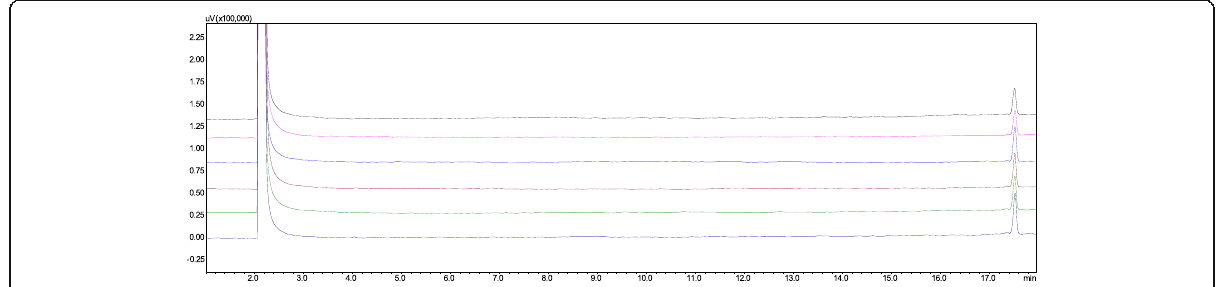
Fig. 6 Overlay chromatogram of standard squalene